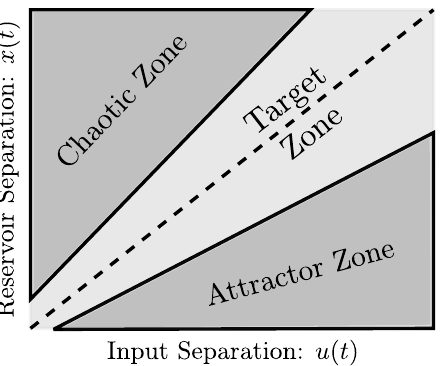
Figure 1. Separation Ratio Graph based on [34]. Graphical representation of the phase transition between chaos and order. Systems in the target zone are said to possess both a good separation property and ideal dynamic behaviour to produce optimal